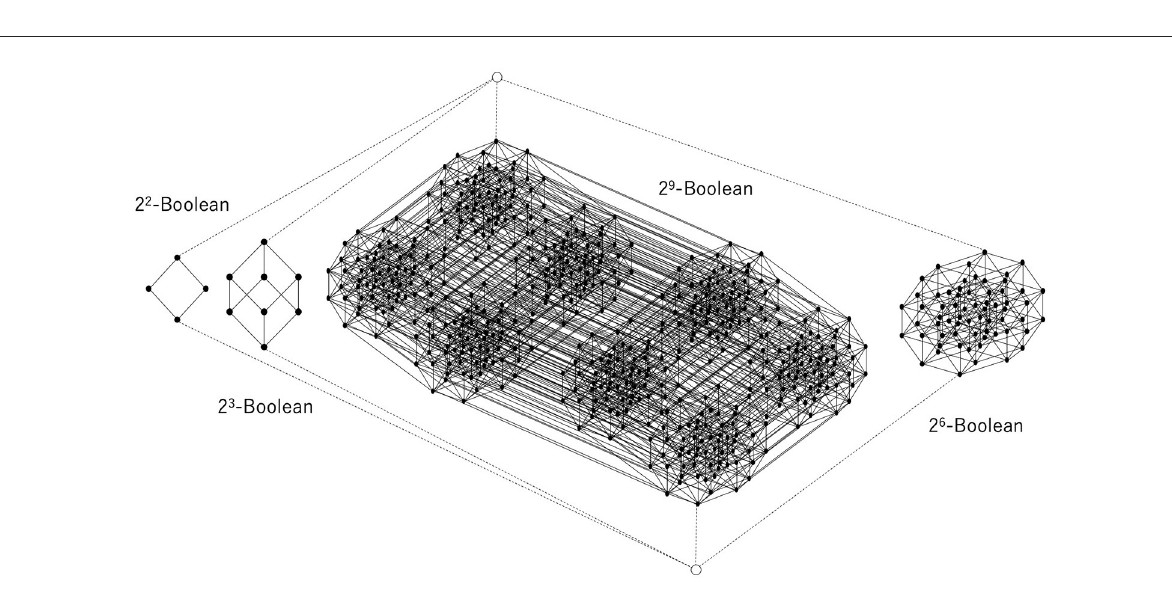
and they are connected to the least and the greatest element of each Boolean lattice by broken lines, which implies that the greatest element of each Boolean lattice is the same as D and that the least element of each Boolean lattice is the empty